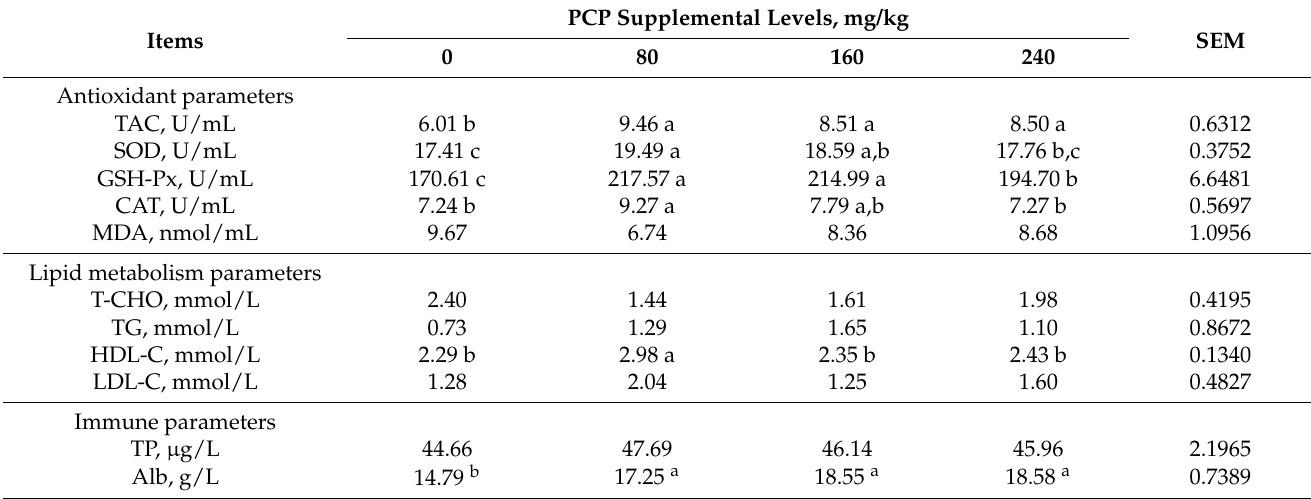
Table 3. Effect of anthocyanin-rich PCP on blood biochemical indexes of growing